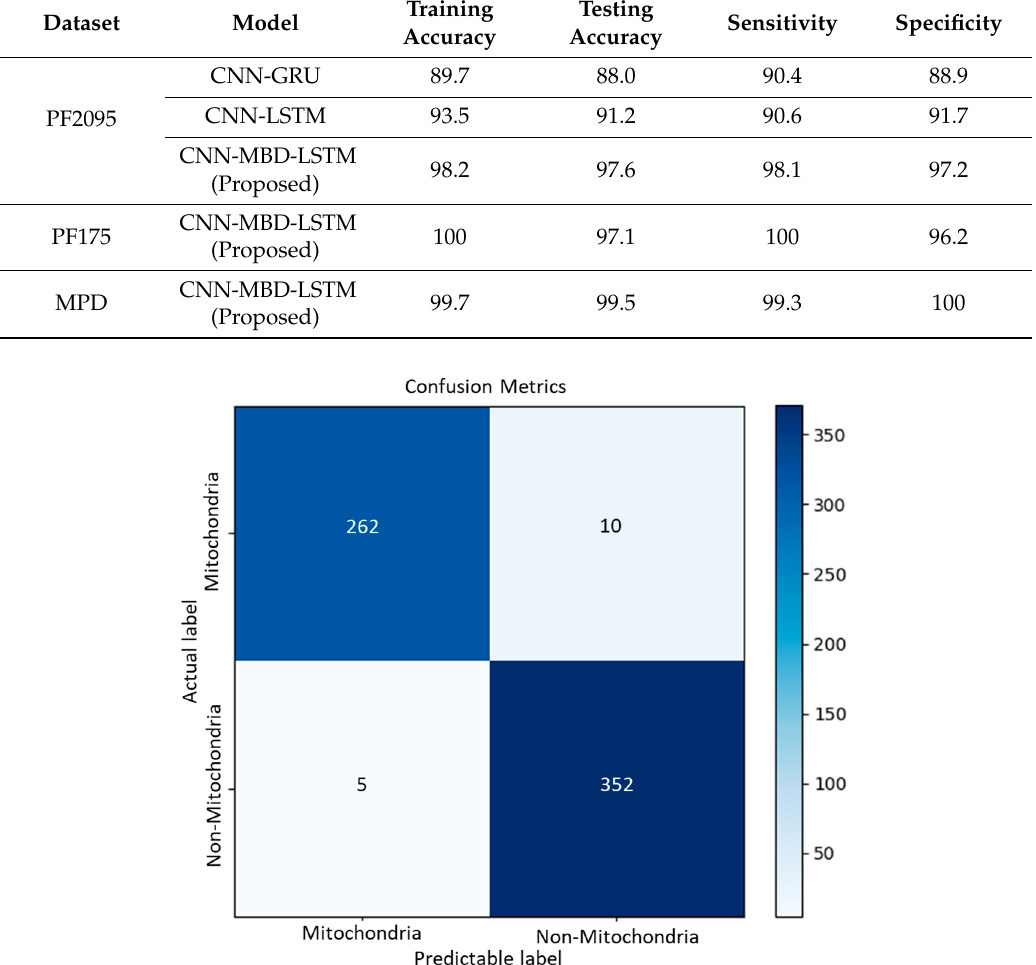
Figure 4. Confusion metrics of the proposed method over the PF2095 dataset. Table 3. Training and testing performance of the MPPIF-NET on different models and datasets.